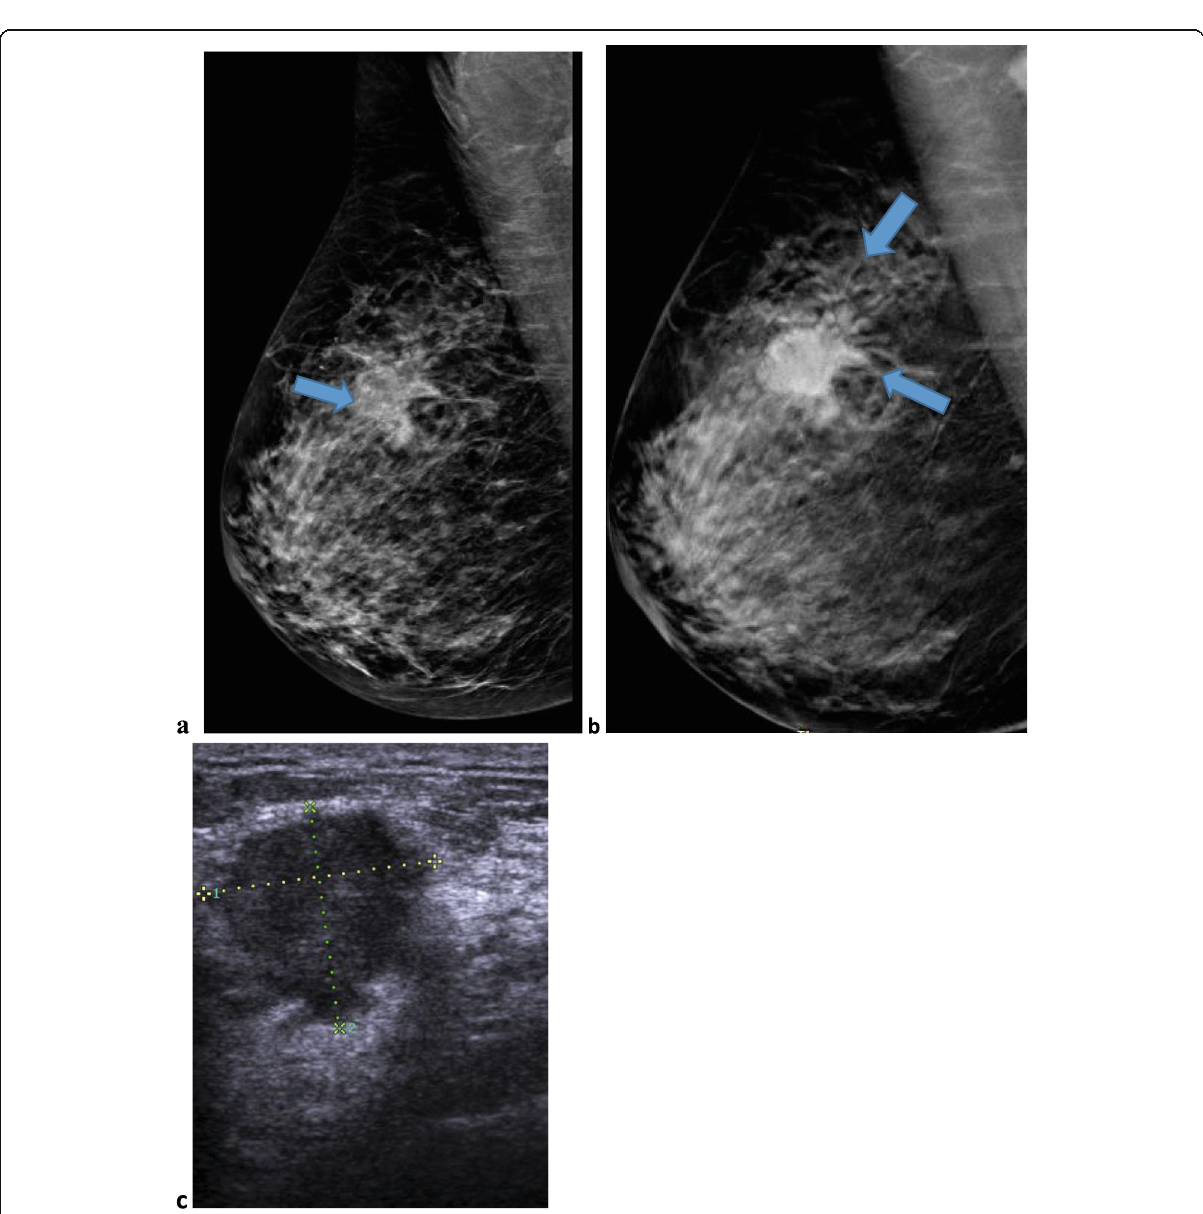
Fig. 5 A 52-year-old patient, presented with right breast mass. a FFDM in MLO view of the right breast: it shows heterogeneously dense parenchyma (ACR c ). The right upper outer quadrant shows a round mass with irregular partly obscured margins. No suspicious calcifications are seen (BIRADS IVa), b DBT MLO view of the right breast shows right upper outer quadrant round mass with spiculated, microlobulated margins with an additional area of architecture distortion (BIRADS IVc), c US examination reveals hypoechoic irregular mass, longitudinally oriented perpendicular to surface with avid vascularity on color Doppler. TRU CUT biopsy revealed: right breast suspicious lesion (IDC). Speculations are more clearly visible with